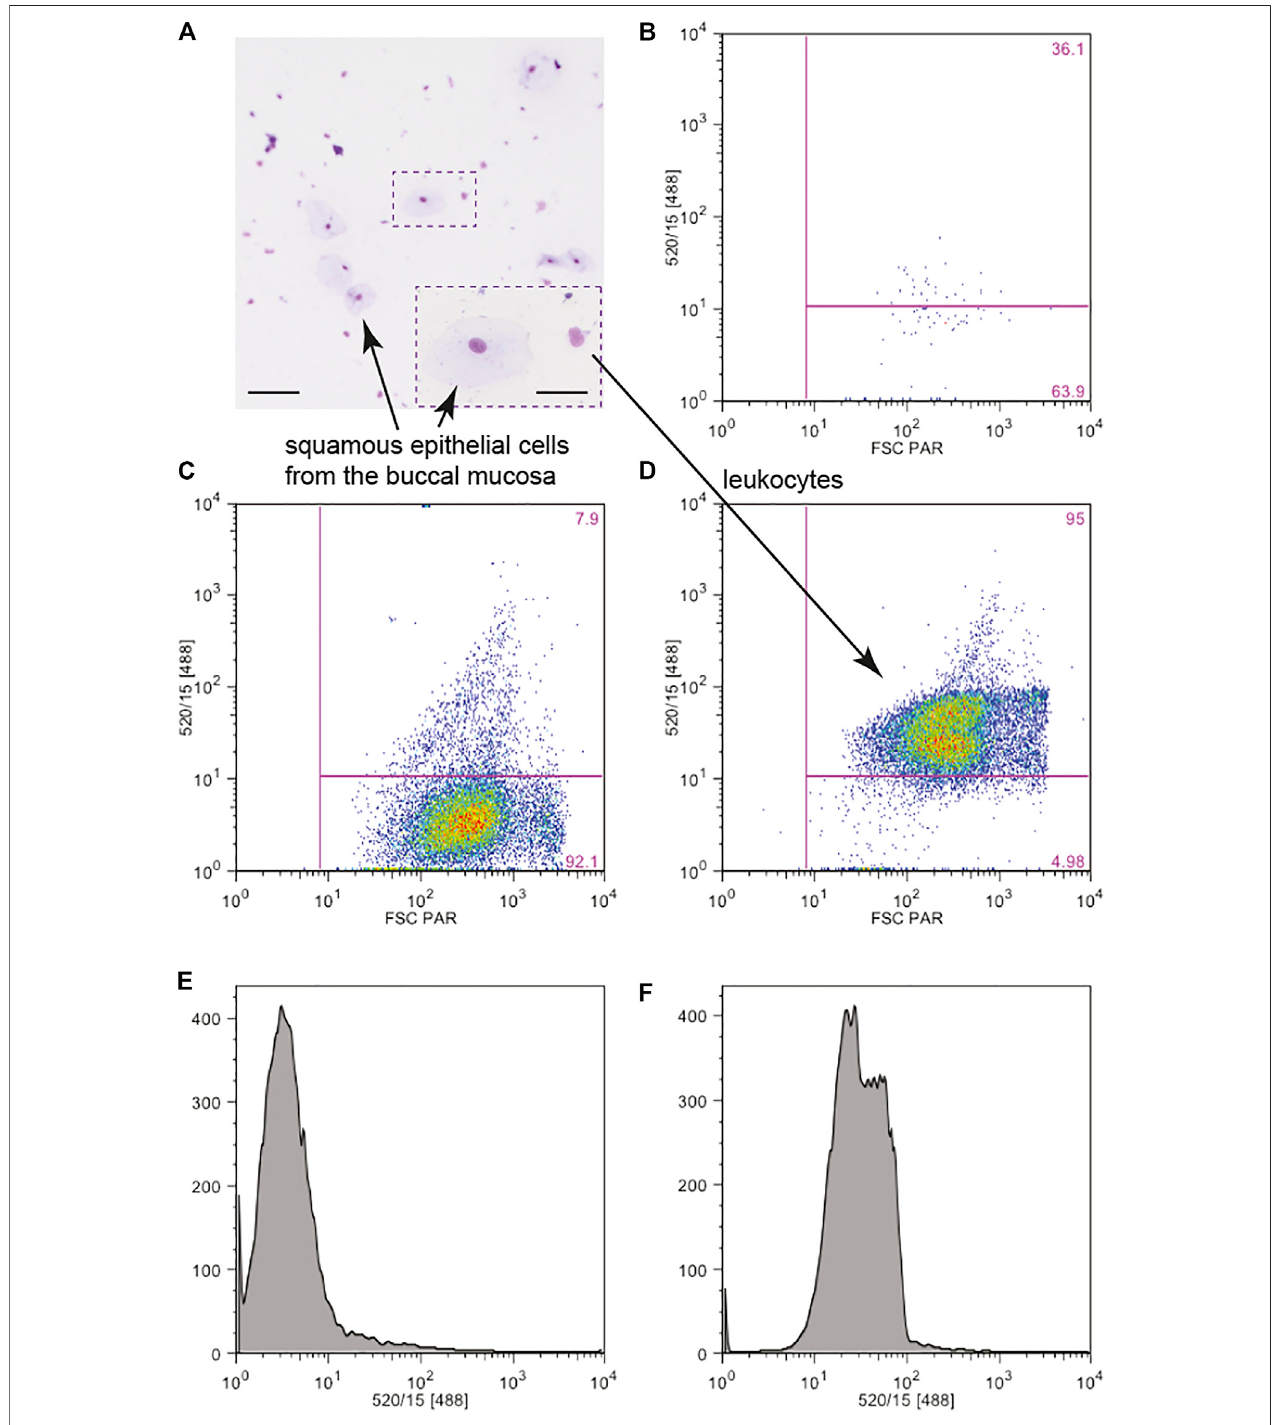
FIGURE3| Salivacontainsepithelialbuccalcellsandleukocytes. (A) Wright-Giemsastainingofsalivaindicatesthepresenceoflargebuccalcellsaswellassmaller cells resembling leukocytes. The rectangular area demarcated by the dotted line is enlarged in the right, bottom corner. Lower magni fi cation scale bar — 100 um, higher magni fi cation scale bar — 30 um. Cell sorting and fl ow cytometry showed the presence of leukocytes in saliva. (B) The unlabeled cells were not detected. (C) A representative 3D density scatter plot shows that most of the cells, when unlabeled, clustered into a homogeneous group in one gating window below the fl uorescent threshold based on size representing leukocytes. (D) Upon labeling with fl uorescent CD45-speci fi c antibodies almost all of cells from (B) shifted above the thresholdandaccumulatedinonegatingwindowindicatingthatthesecellsarehumanleukocytes. (E) Arepresentativehistogramshowingthehomogeneityofunlabeled cells based on size. (F) Upon labeling with fl uorescent CD45-speci fi c antibodies almost all of cells from (E) shifted above the threshold indicating that these cells are human leukocytes. Red lines in (B – D) delineate gating windows. FSC — forward scatter, 520/488 — fl uorescent emission/excitation wavelengths.